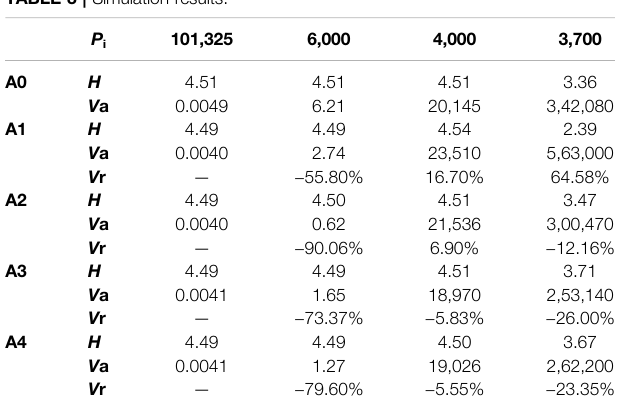
TABLE 3 | Simulation